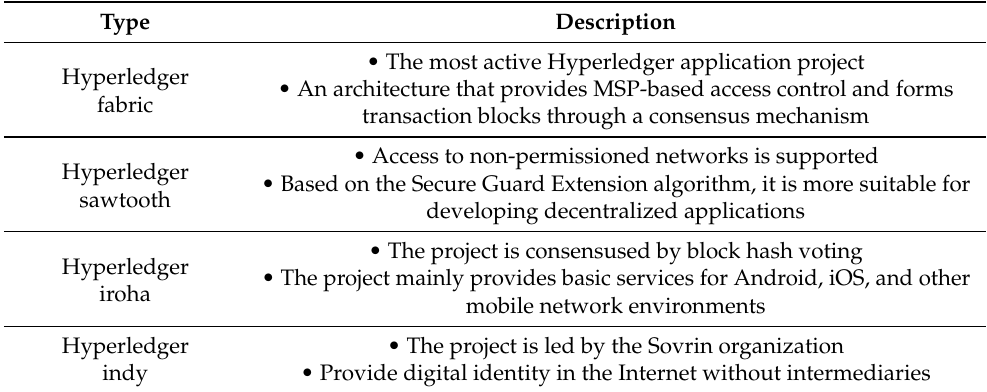
Table 1. The main classification and characteristics of the Hyperledger framework.